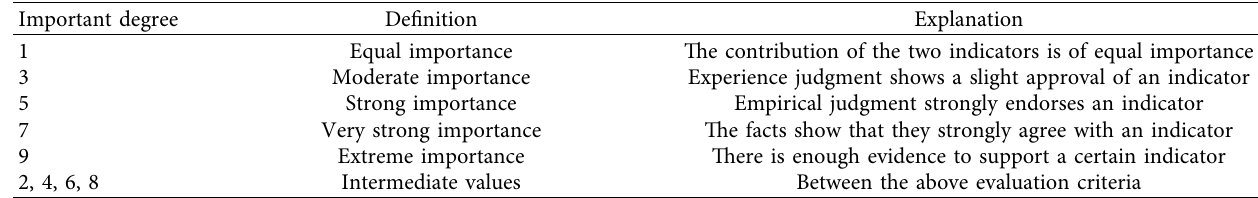
Table 2: ANP evaluation scale table.